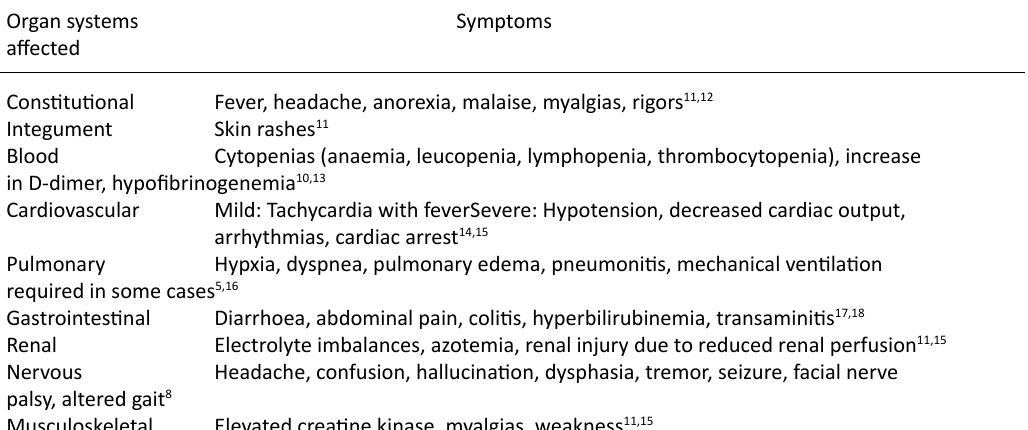
Table 1. Symptoms associated with CRS and sites of body affected Organ systems